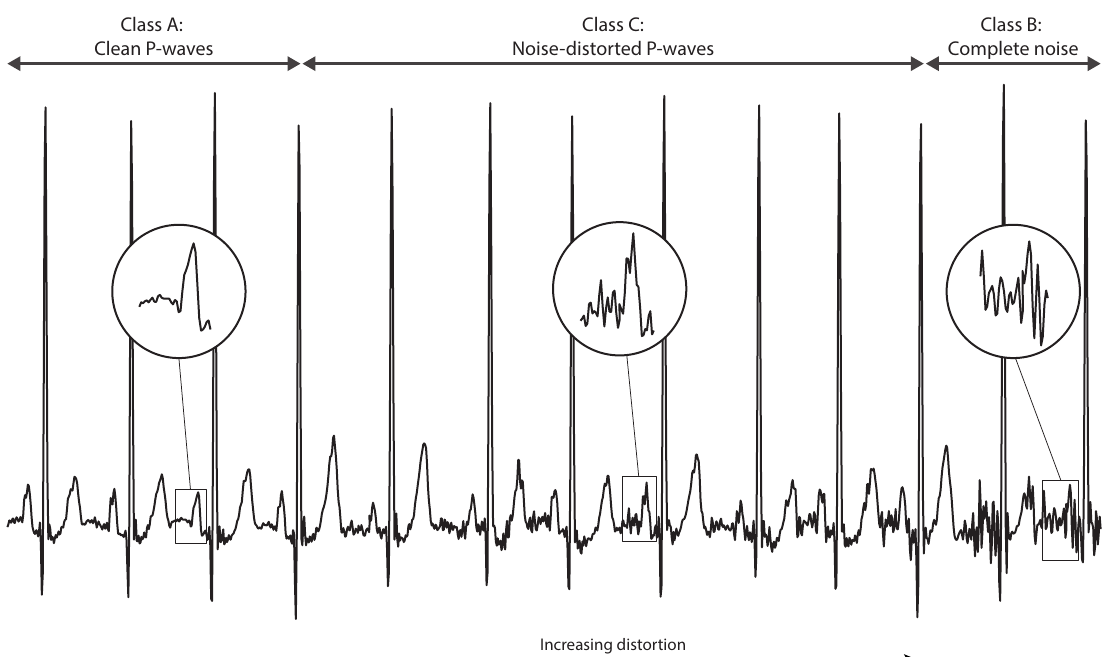
Figure 1. P-waves were classified into three different classes: high-quality clean P-waves (class A), unreliable, noise-distorted P-waves (class C), and complete noise or absent P-waves (class B). Even though class C P-waves had some resemblance to normal P-wave morphology, they were still considered unreliable. For that class, the degree of distortion varied from mildly to heavily distorted.